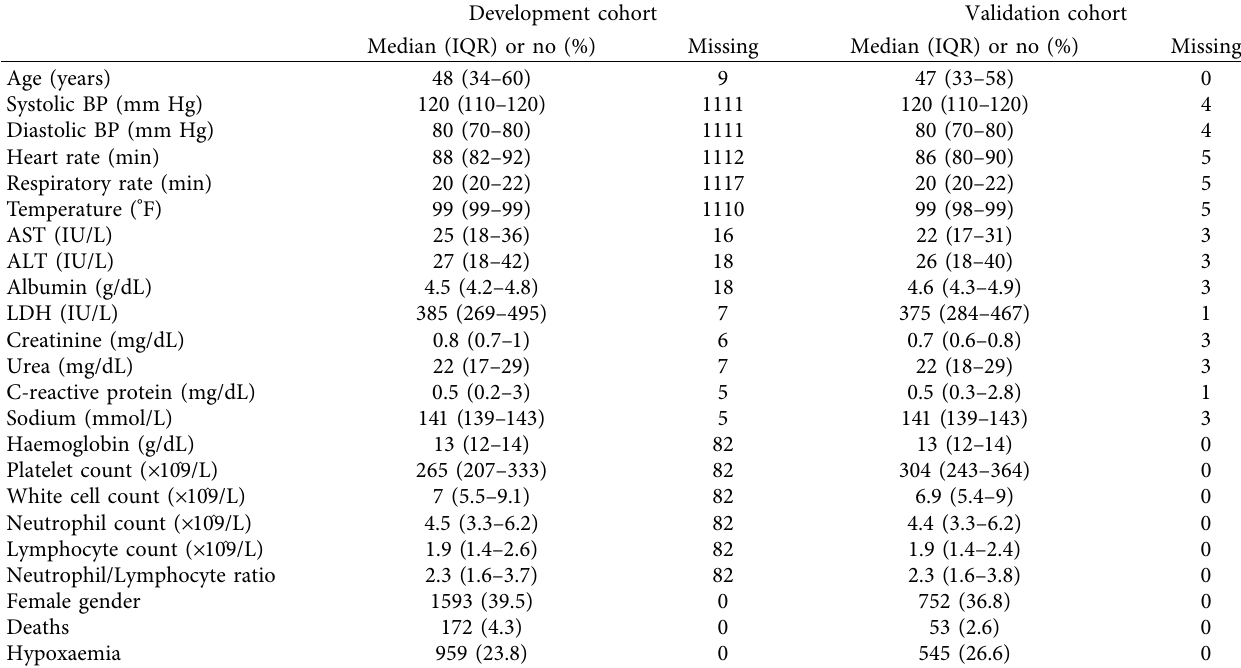
Table 1: Characteristics of patients in the development and the validation